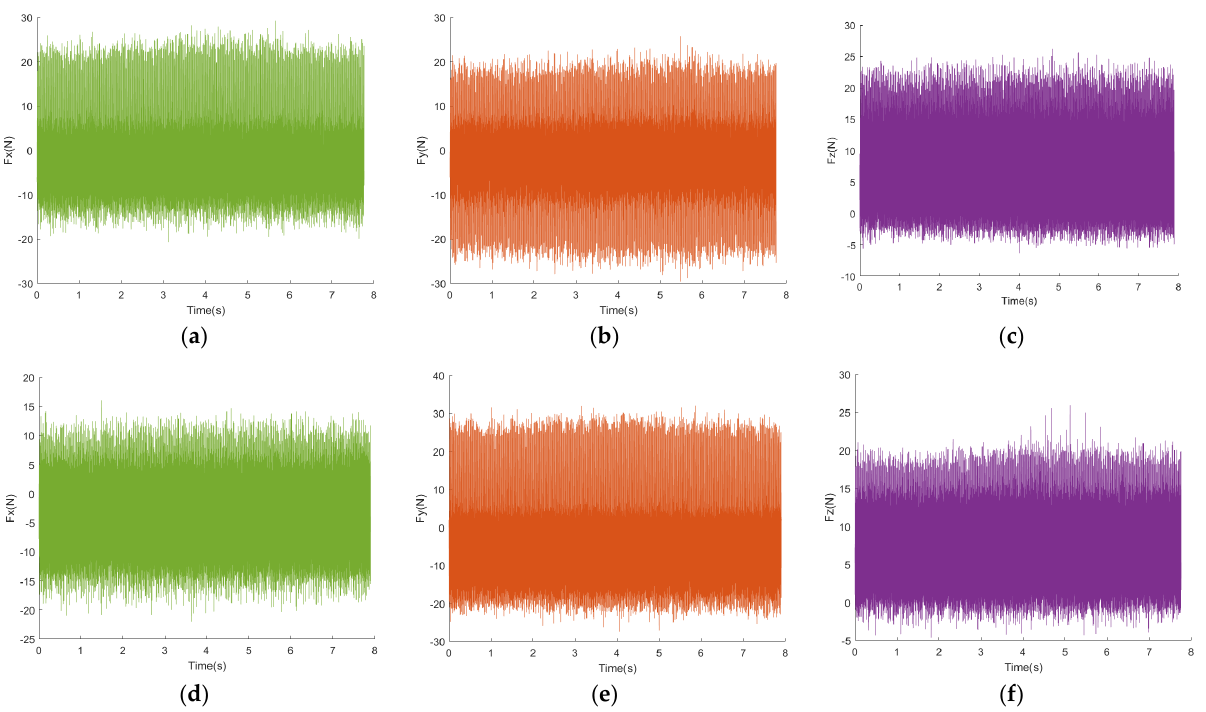
Figure 21. Comparison of workpiece cross section profile curve between DACT and BEM.